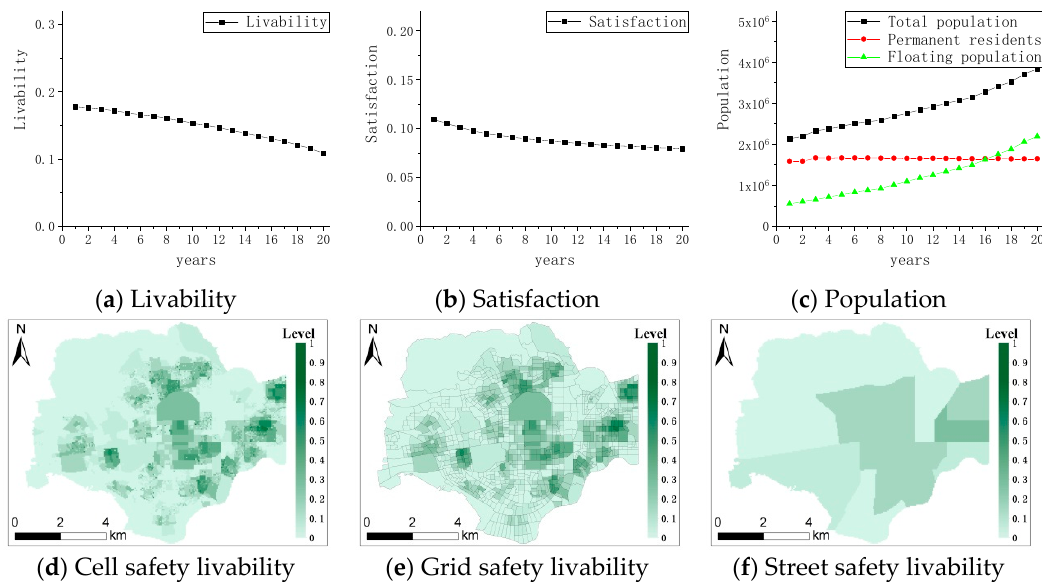
Figure 12. Scenario 2 results.